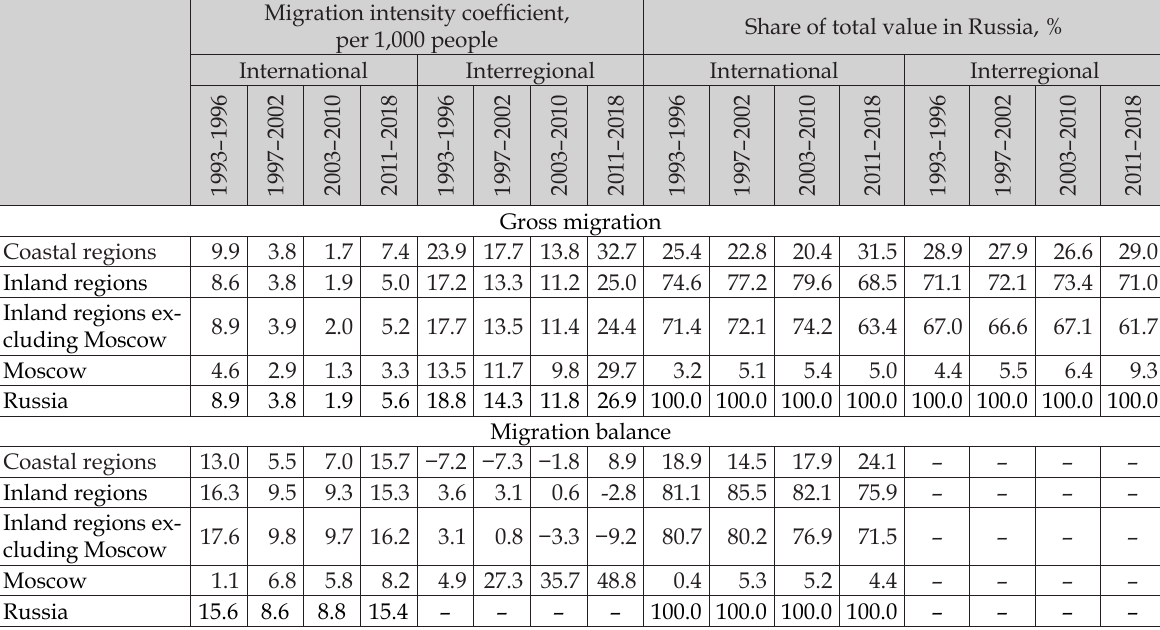
Table 2. Gross migration and balance of migration in coastal and inland regions of Russia in 1993–2018. Migration intensity